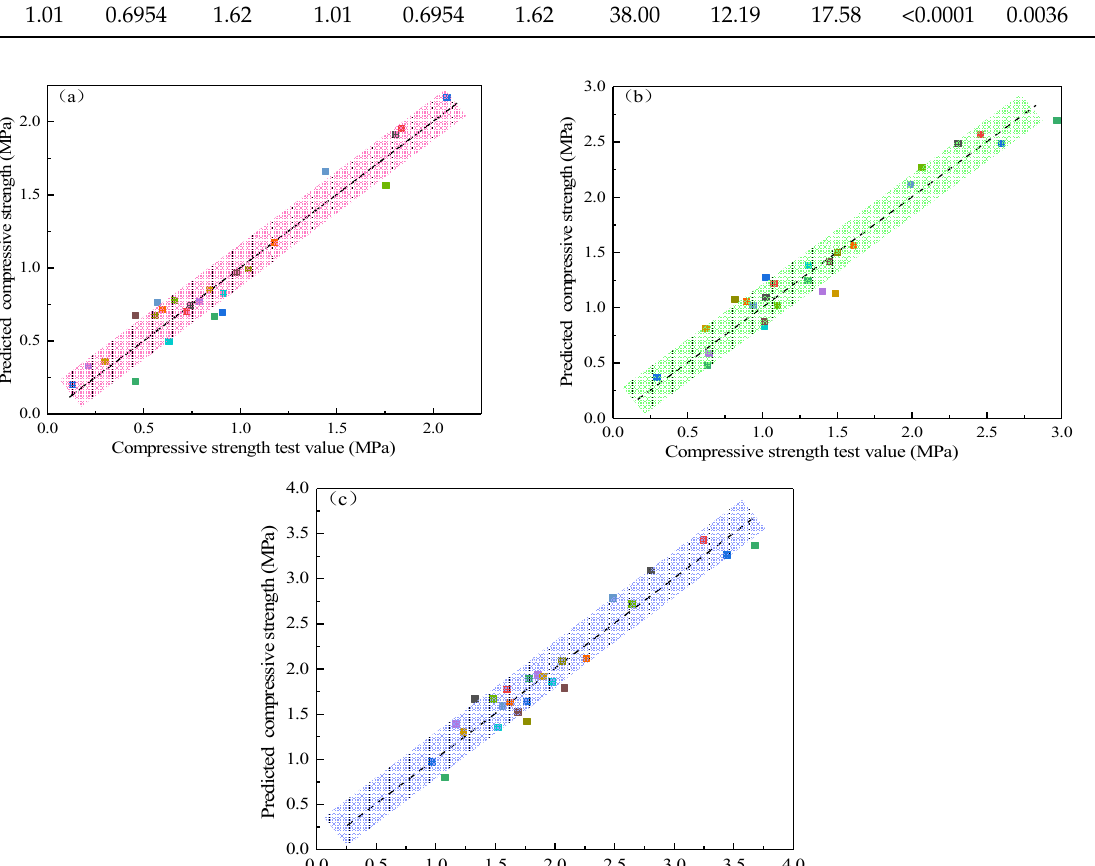
Figure 6. Comparison of experimental and predicted values of filler strength: ( a ) 3 day; ( b ) 7 day; ( c ) 28